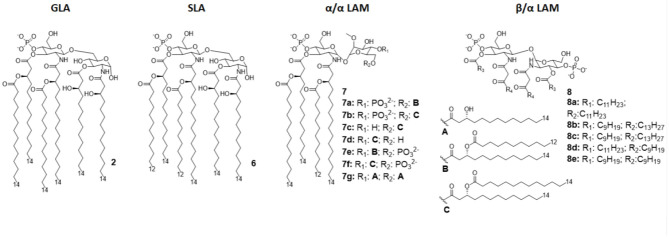
Disaccharide-based synthetic Lipid A analogs. GLA is a fully synthetic MPLA. SLA is a second generation GLA optimized to be more compatible with MD-2 (by introducing C12 acyl chains). LAMs are trehalose-derived compound: changing the absolute configuration of the glycoside bond LAM allow the switch from TLR4 agonism to antagonism.